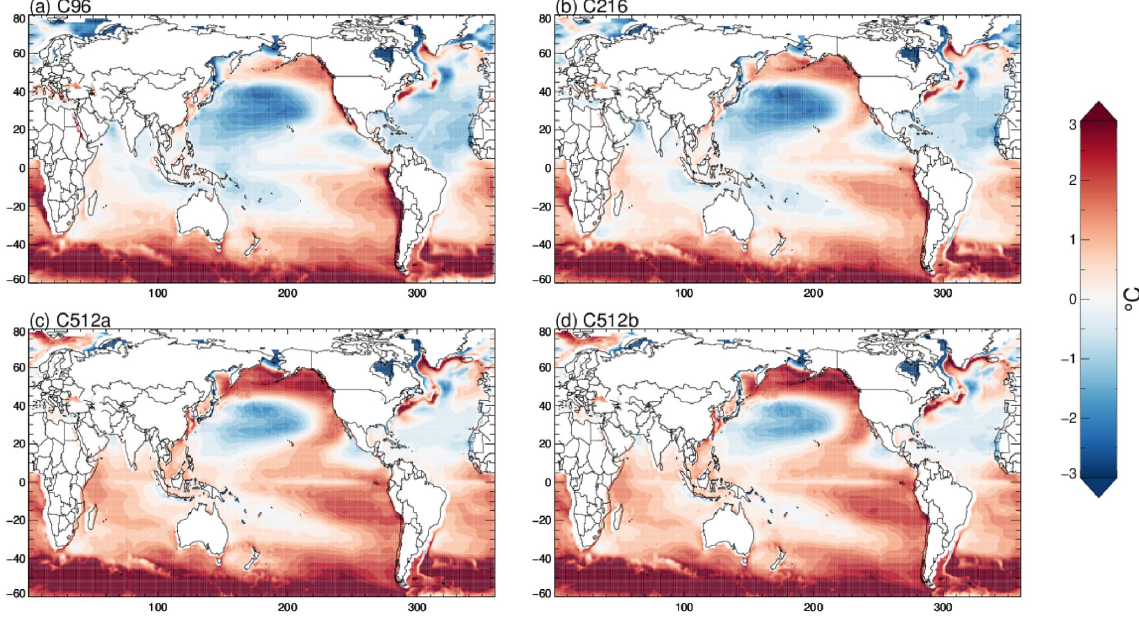
Figure 3. Annual mean SST bias in the coupled simulations relative to observations (1870–2010 HadISST).